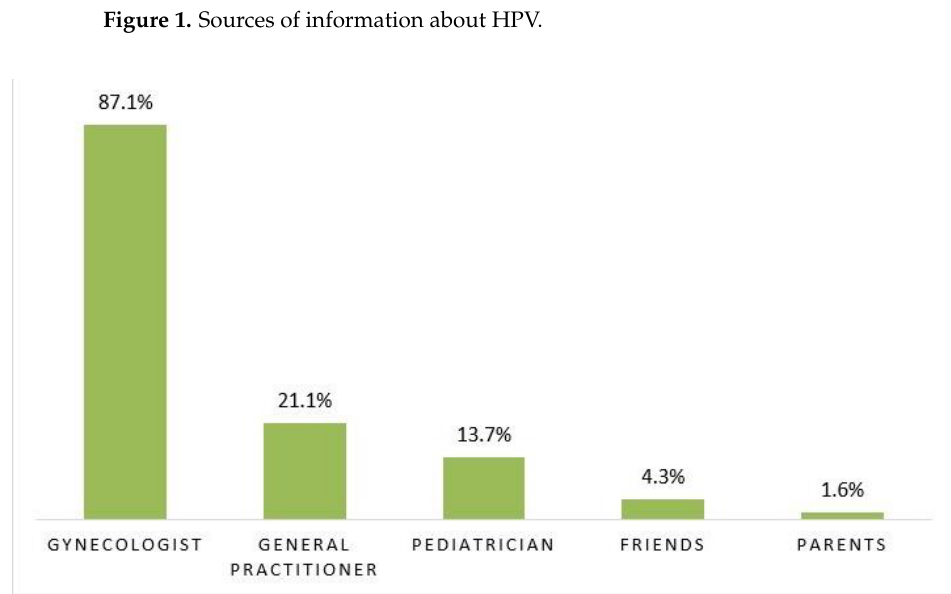
Figure 2. Preferable sources of information about HPV vaccine.